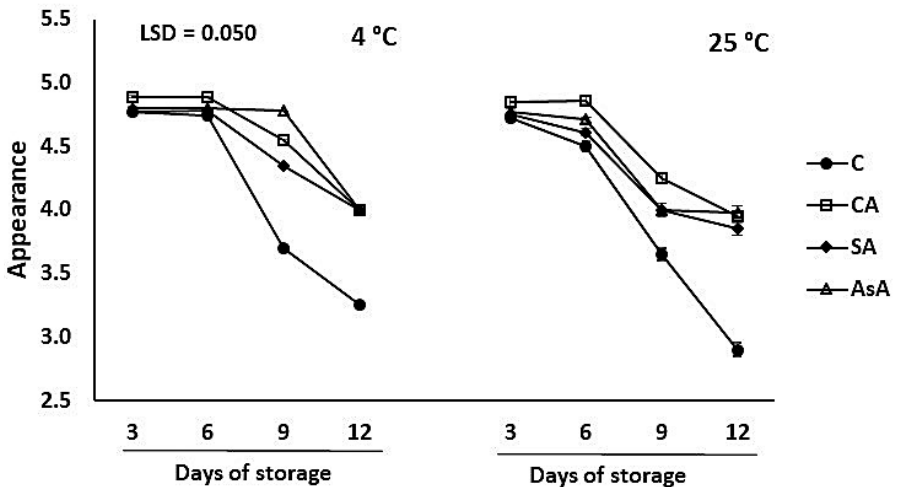
Figure 2. Effects of bio-stimulants, control B (C), citric acid (CA), salicylic acid (SA) and ascorbic acid (AsA), storage period SP (3, 6, 9 and 12 days) and storage temperature T (4 °C and 25 °C) on appearance of okra pods. Error bars are the ± SD of the means of three biological replicates for each temperature condition. LSD values ( p ≤ 0.05) for B = 0.02, SP = 0.02, T = 0.01, B × SP = 0.04, B × T = 0.03 and SP × T = 0.03. LSD for B × SP × T is displayed on the figure.